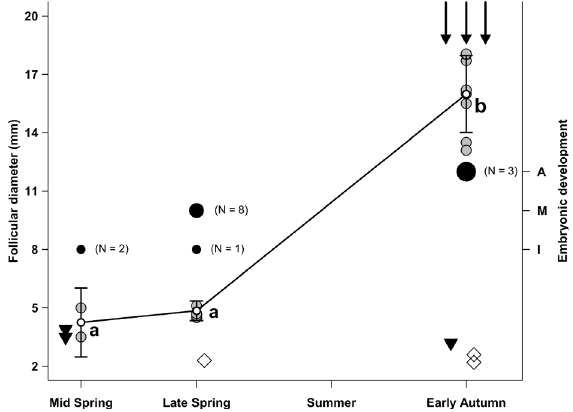
Figure 3. Follicular and embryonic development through the seasons of Phymaturus extrilidus females. Mean ± standard deviation of the follicular diameter of vitellogenic females is represented by empty dots and mustaches. Follicular diameter of the vitellogenic females (grey circles), post-partum females (black triangles) and non-reproductive females (white diamonds) are indicated. Occurrence of embryos with initial (I), medium (M), and advanced (A) degree of development are represented by black circles (the circles grow as embryonic development progress), and arrows indicated parturition dates (Gómez Alés, R. pers. comm.). Number of females with embryos in each stage of development are indicated between parentheses (N). The letters indicate significant differences according to Post Hoc